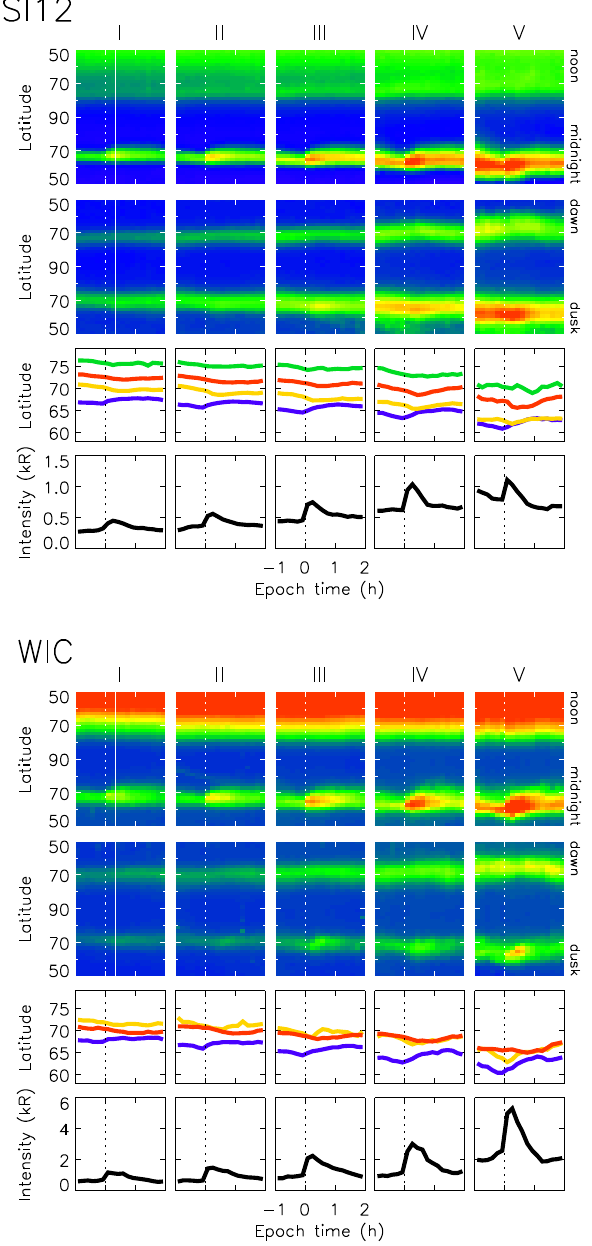
Fig. 5. The results of the superposed epoch analysis of the SI12 (upper panels) and WIC (lower panels) observations. These are pre- sented as keograms along the noon-midnight and dawn-dusk merid- ians as a function of epoch time. Also indicated are the variations in latitude of the peak in intensity along the midnight (blue), noon (green), dawn (red), and dusk (yellow) meridians, and the midnight oval intensity